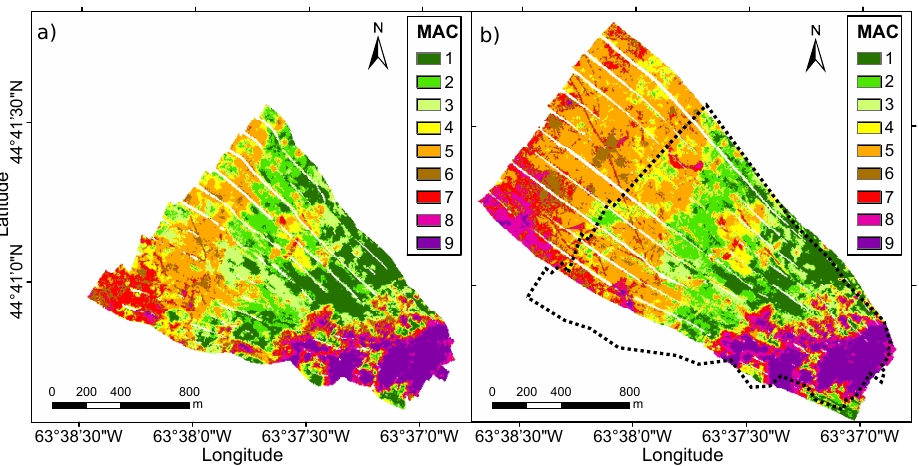
Figure 13. MAC map of the Bedford Basin in ( a ) 2016 and ( b ) 2017 obtained from the combination of the individual single frequency maps. The spatial resolution is 5m by 5m.